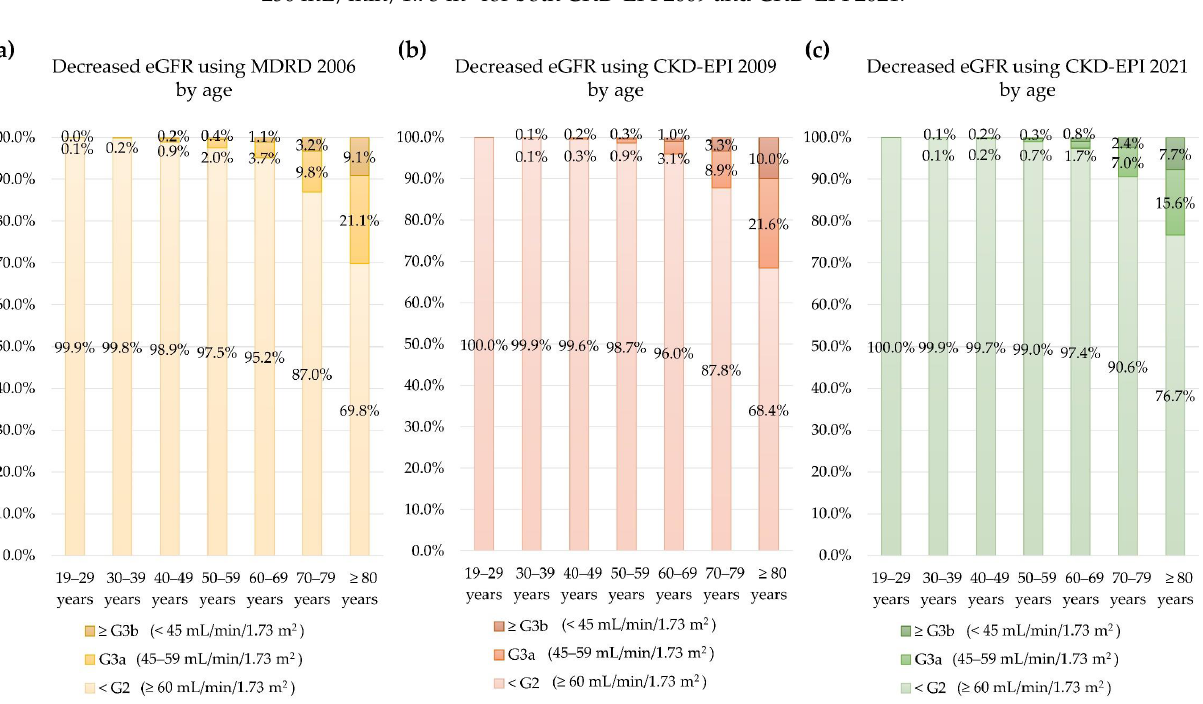
Figure 1. Correlation between age and estimated glomerular filtration rate (eGFR) by age using ( a ) MDRD 2006, ( b ) CKD-EPI 2009, and ( c ) CKD-EPI 2021. Y-axis represents eGFR and x-axis represents age. The maximum scale of the y-axis is 600 mL/min/1.73 m 2 for MDRD 2006, and 250 mL/min/1.73 m 2 for both CKD-EPI 2009 and CKD-EPI 2021.